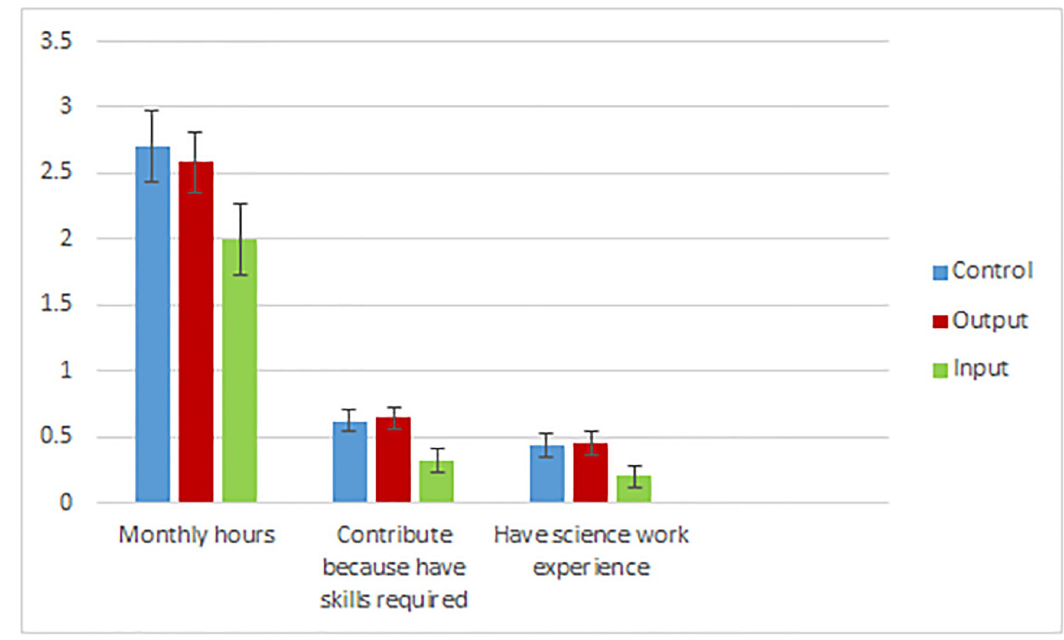
Fig 4. Contributor characteristics by treatment groups. Figure plots the average Zooniverse contributor characteristics across control and treatment pages along with standard errors.